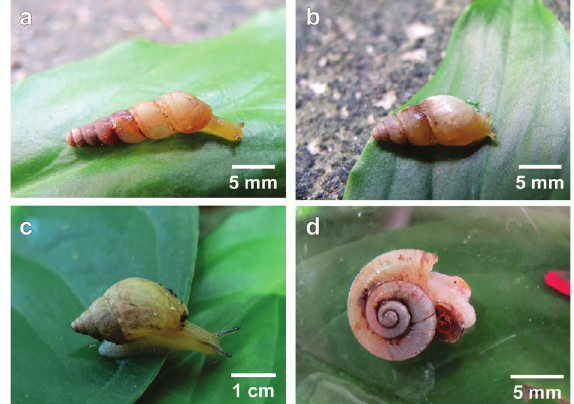
Figure 2. Alive specimens. a. Subulina octona (CMIOC 11202), b. Leptinaria unilamellata (CMIOC 11138), c. Bulimulus tenuissimus (CMIOC 11130), d. Neocyclotus prominulus (CMIOC